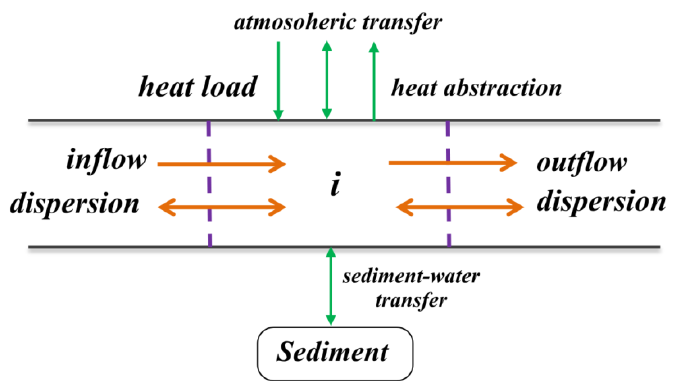
Figure 3. Temperature balance for the i -th period of rivers.